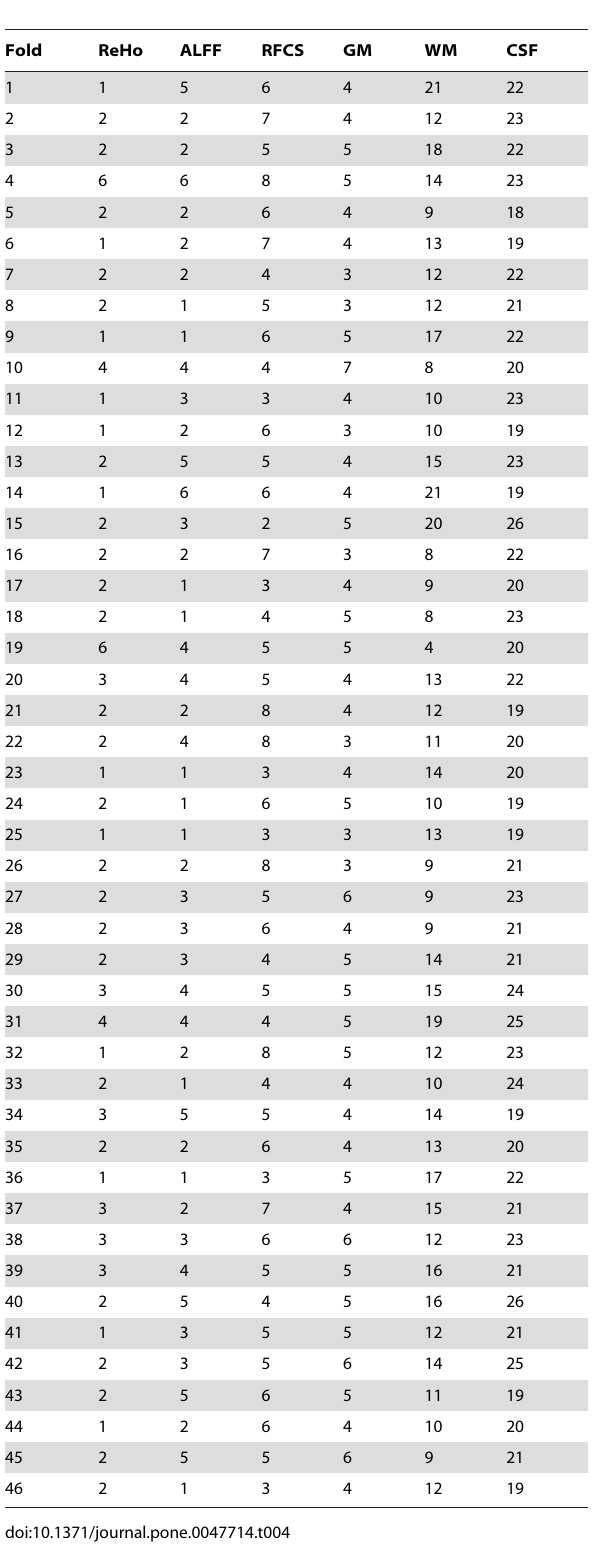
Table 4. The number of features retained in the multi-model method per fold.